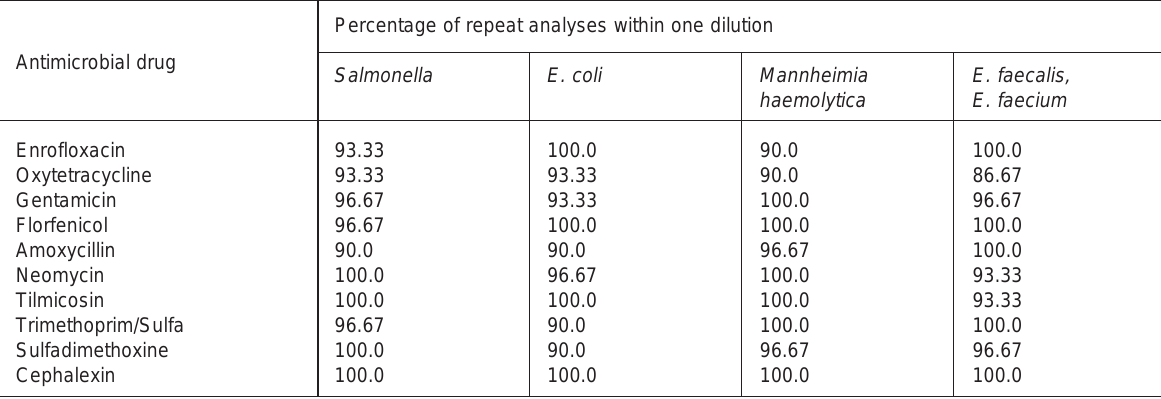
TABLE 2 Repeatability results of duplicate testing of selected antimicrobial drugs against four bacterial species Percentage of repeat analyses within one dilution Antimicrobial drug Salmonella E. coli Mannheimia